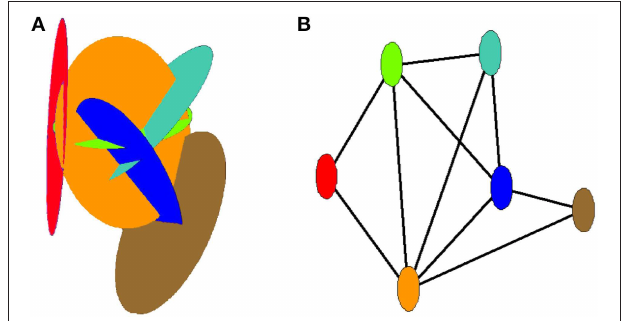
FIGURE 4 | Illustration of how the structure of the desert rose is transformed into a graph by defining each disk as a node and linking nodes which represent intersecting disks. (A) Representation of a small desert rose made up by six disks. (B) Equivalent graph representation where the color of the nodes correspond to the color of the disks they